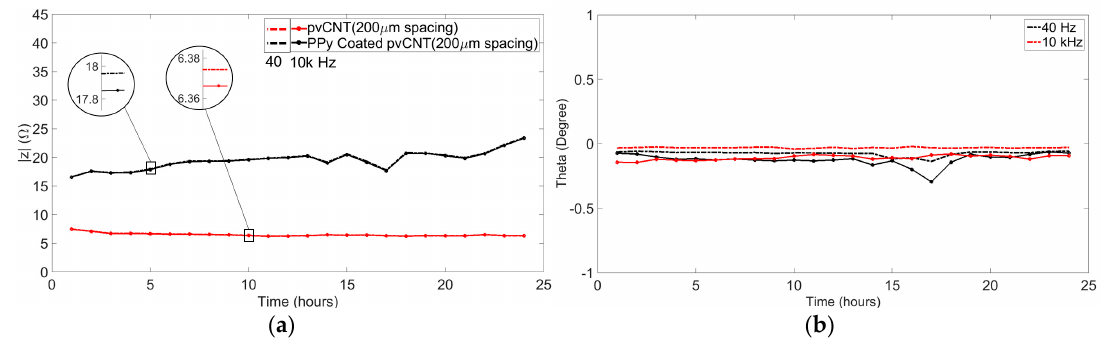
Figure 6. The amplitude ( a ) and phase ( b ) of the impedance of non-coated pvCNT electrode and PPy-coated pvCNT electrode for a long duration of 24 h.